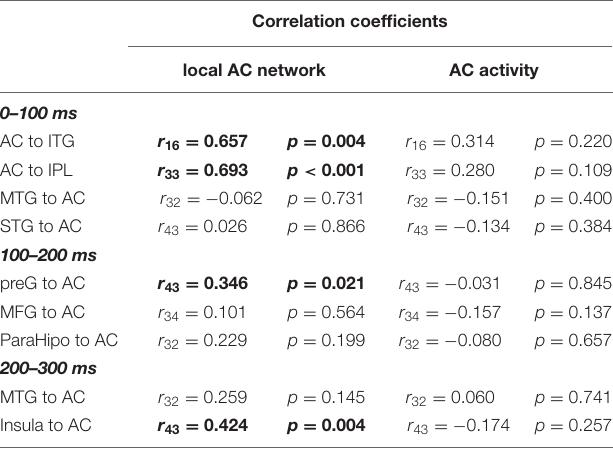
TABLE 4 | Pearson correlation coefficients between extrinsic networks and the local AC